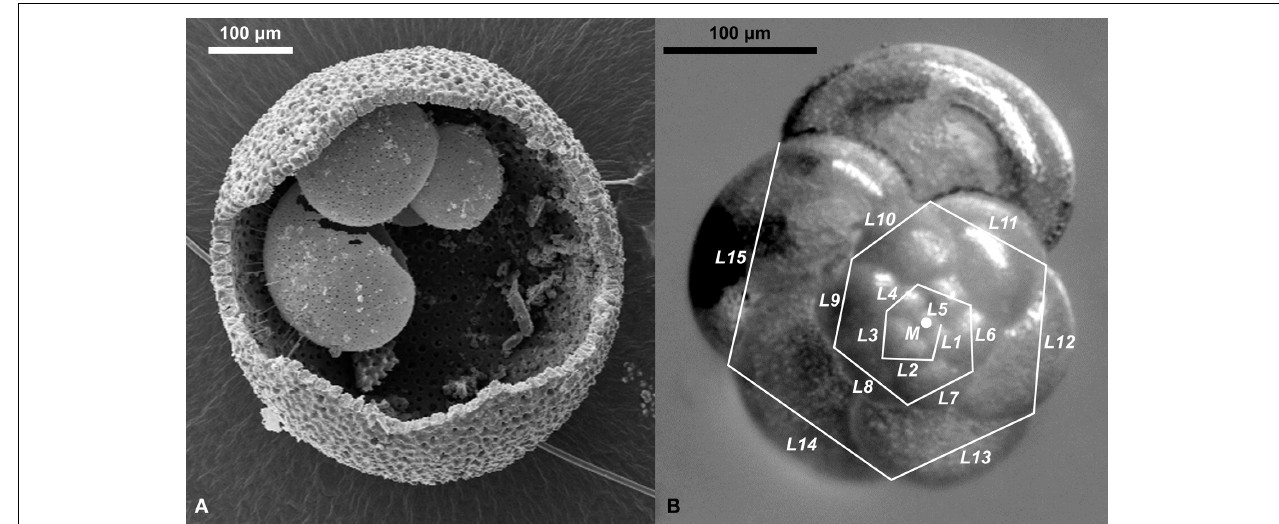
FIGURE 2 | Depiction of species used in this study. (A) Scanning electron micrograph of a cracked open shell of Orbulina universa , showing the delicate trochospiral juvenile shell preserved within the spherical terminal chamber. (B) Measurement of the incremental growth in Globorotalia scitula . Straight lines were drawn between consecutive chamber sutures and their length was measured ( L 1– L 15). The relative